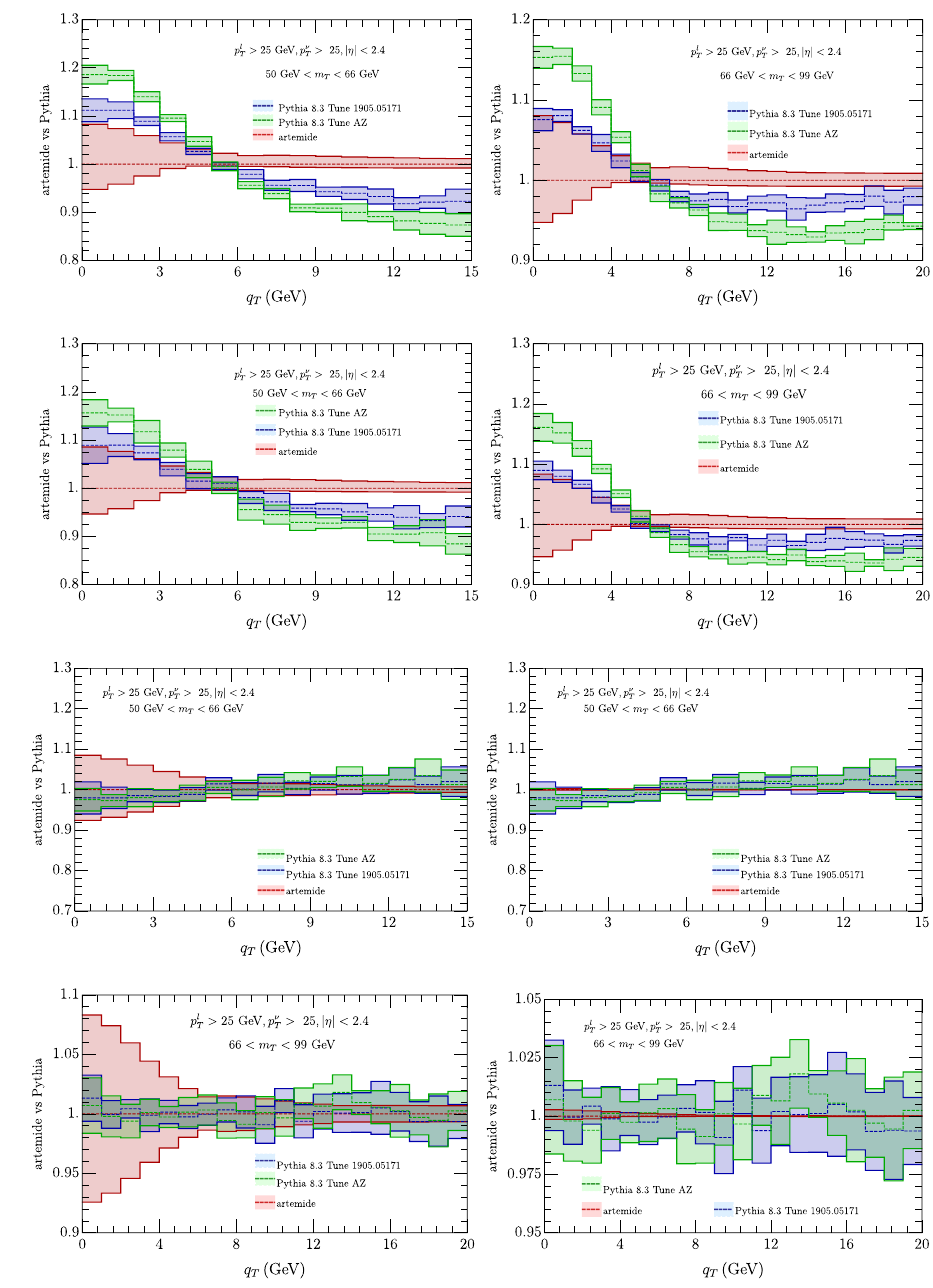
Fig. 9 Comparison of Artemide cross section with Pythia 8.3 AZ tune as in [60] (blue band) and as in the original ATLAS release (green band) for W + (top panels) and W − (low panels). The Artemide error comes from scale variations, the Pythia errors are commented in the text